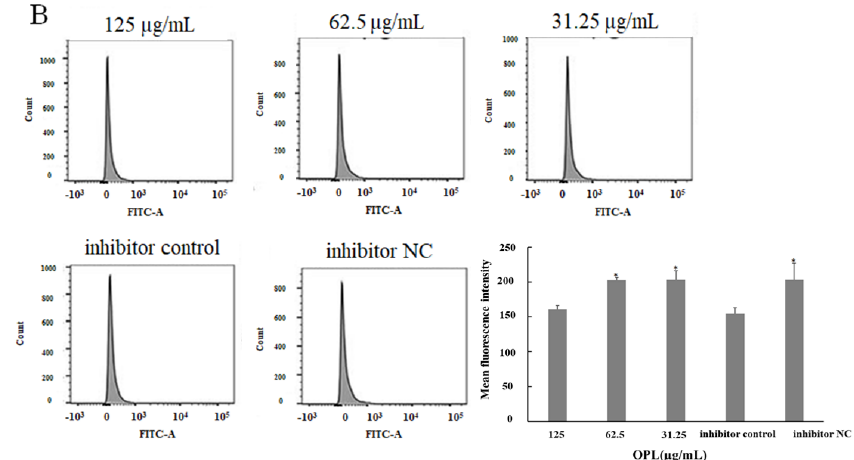
Figure 5. The effect of OPL on the phagocytosis of FITC-Dextran. ( A ): Average fluorescence intensity of transfected miR-4796 mimic group; ( B ): average fluorescence intensity in the transfected miR-4796. Each value represents the mean ± SD ( n = 3). * p < 0.05, ** p < 0.01 compared with the control group.